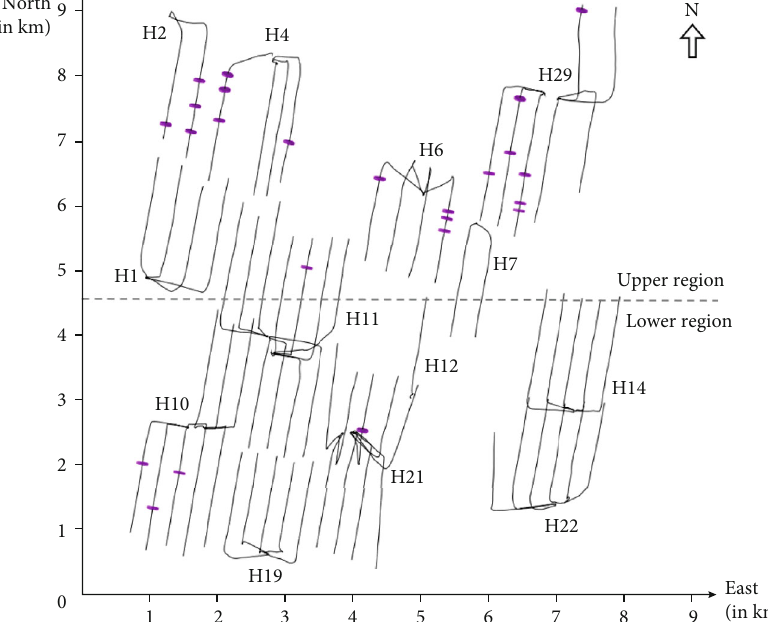
Figure 1: The spatial distribution of casing deformation in the Ning209 block. Purple lines represent the positions of casing deformation. Table 1: Summary of treating parameters optimization in the Ning209 block. Treating parameters optimization Number of intersecting faults Number of casing